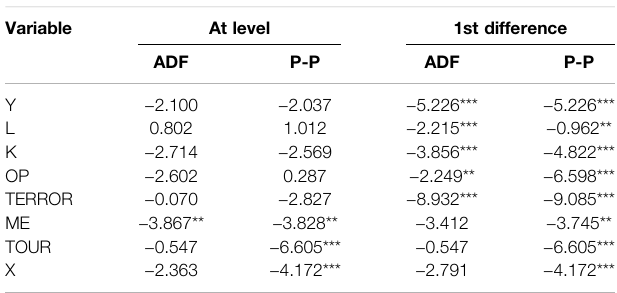
TABLE 2 | Unit root analysis without